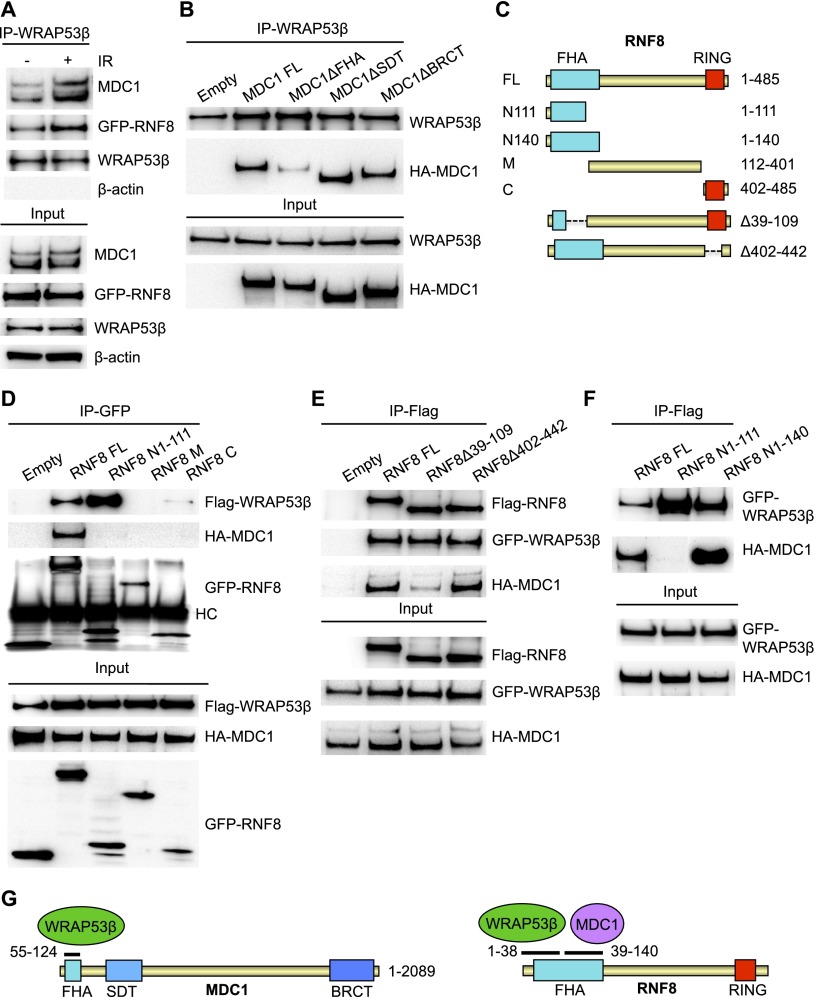
WRAP53β binds MDC1 and RNF8 via their FHA domains. (A) U2OS cells were either left untreated or irradiated with 6 Gy of IR, and, 30 min, later immunoprecipitation of WRAP53β was performed, followed by immunoblotting of WRAP53β, MDC1, GFP-RNF8, and β-actin. (B) U2OS cells were transfected with the indicated HA-MDC1 constructs for 16 h and irradiated with 2 Gy, and, 30 min later, immunoprecipitation of WRAP53β was performed, followed by immunoblotting of WRAP53β and HA-MDC1. (C) Schematic illustration of RNF8 deletion constructs. (D) U2OS cells were transiently transfected with EGFP-RNF8 plasmids, HA-MDC1, and Flag-WRAP53β for 16 h; irradiated; and subjected to immunoprecipitation of GFP followed by immunoblotting for GFP-RNF8, Flag-WRAP53β, and HA-MDC1. (HC) Heavy chain of the antibody. U2OS (E) and H1299 (F) cells were transiently transfected with Flag-RNF8 plasmids, HA-MDC1, and EGFP-WRAP53β for 16 h; irradiated; and subjected to Flag immunoprecipitation followed by immunoblotting for the indicated proteins. (G) Schematic illustration of the domain architecture of MDC1 and RNF8, where black lines mark WRAP53β- and MDC1-binding sites. Numbers indicate amino acids.